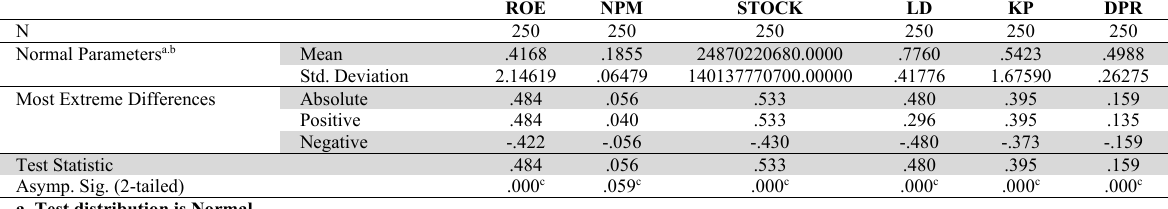
Data normality with the One-Sample Kolmogorov-Smirnov Test